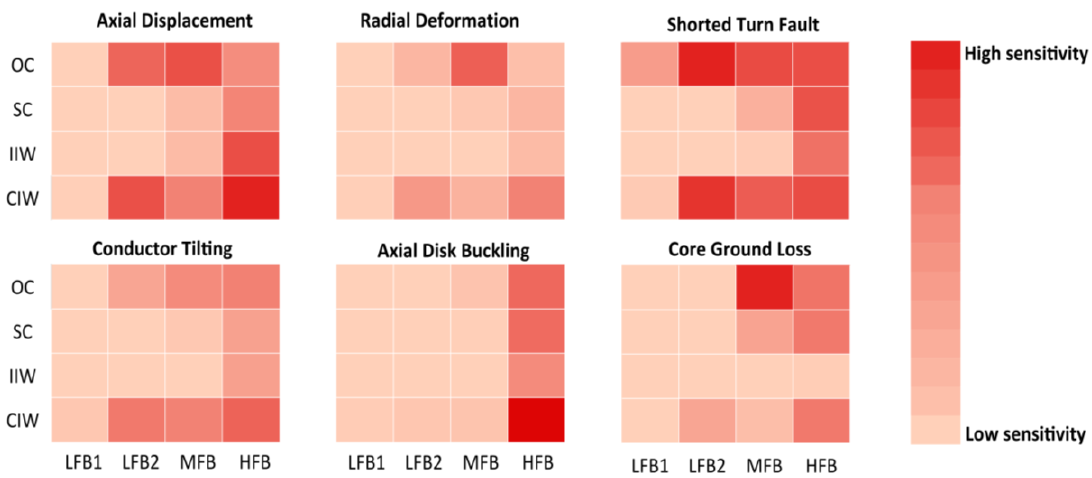
Figure 27. Deviation patterns based on the minimum value of SDD (MSDD) for fault classification.